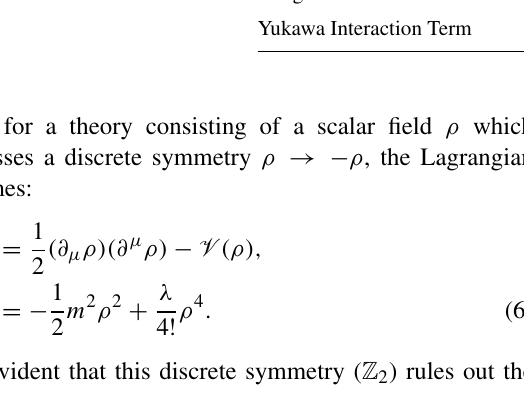
Table 1 Operator classification for the renormalizable Lagrangian composed of scalars, spinors, gauge field strength tensors, and covariant